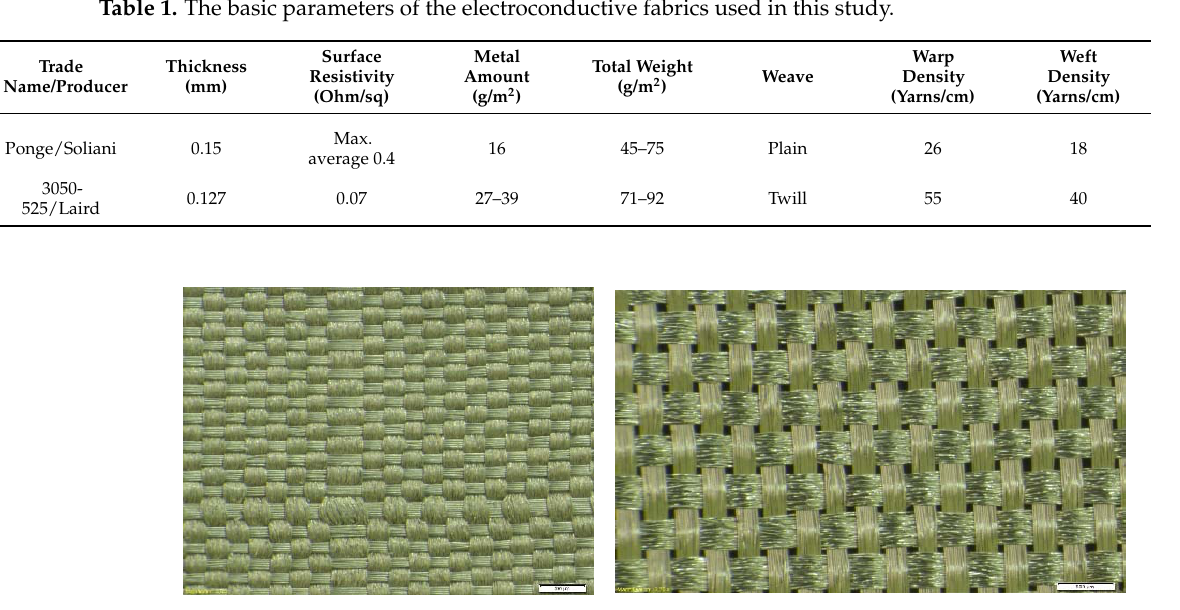
Figure 3. Details of Laird (on the left) and Ponge (on the right) electro-conductive fabric. The basic parameters of the fabrics used as a textile substrate of the tested lines are Table 1. The basic parameters of the electroconductive fabrics used in this study. shown in Table 2. Table 2. Basic parameters of the fabrics used as a textile substrate of the tested lines. Fabric